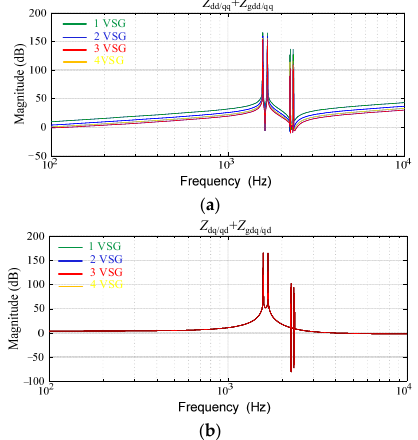
Commented [M3]: Chinese is not allowed, please change into English and revised the figures. it.